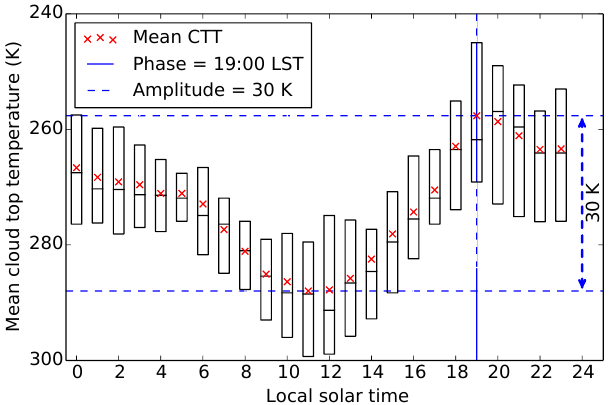
Figure 7. Seasonal mean climatological (September, October, and November 2005–2015) diurnal cycle of cloud top temperature at 3.1 ◦ S, 16.4 ◦ E (western Democratic Republic of the Congo; see cross in Fig. 10). Box plots are used to show the quartiles the shapes of the distribution for each mean point. The amplitude of the diurnal cycle (defined as minimum minus maximum CTT) and the phase (defined as the local solar time (LST) of minimum CTT) are also illustrated.